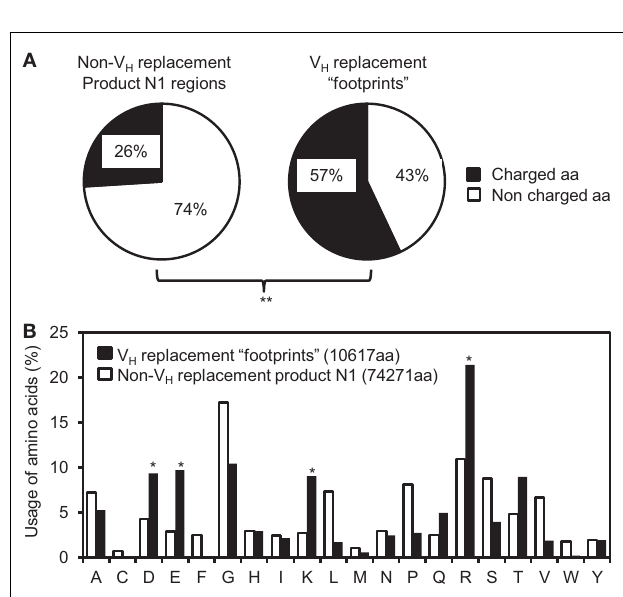
products (black bars) was compared to that of non-V H replacement products (white bars). Statistical significance was determined by using an unpaired t -test. ** p < 0.0001 is considered extremely statistically significant.